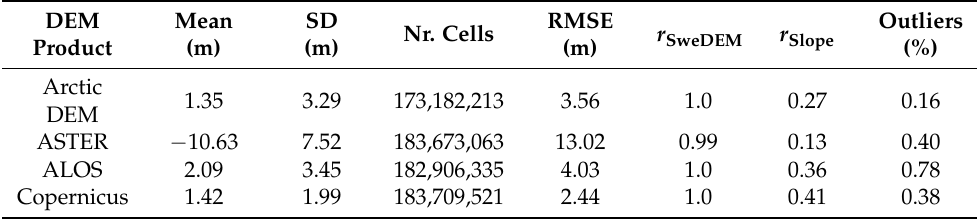
Table 3. Overall statistics of elevation errors for four candidate DEMs. r SweDEM is the correlation coefficient between the elevation of each candidate DEM and the reference DEM, whereas r Slope is the correlation between vertical error and terrain slope derived from the reference